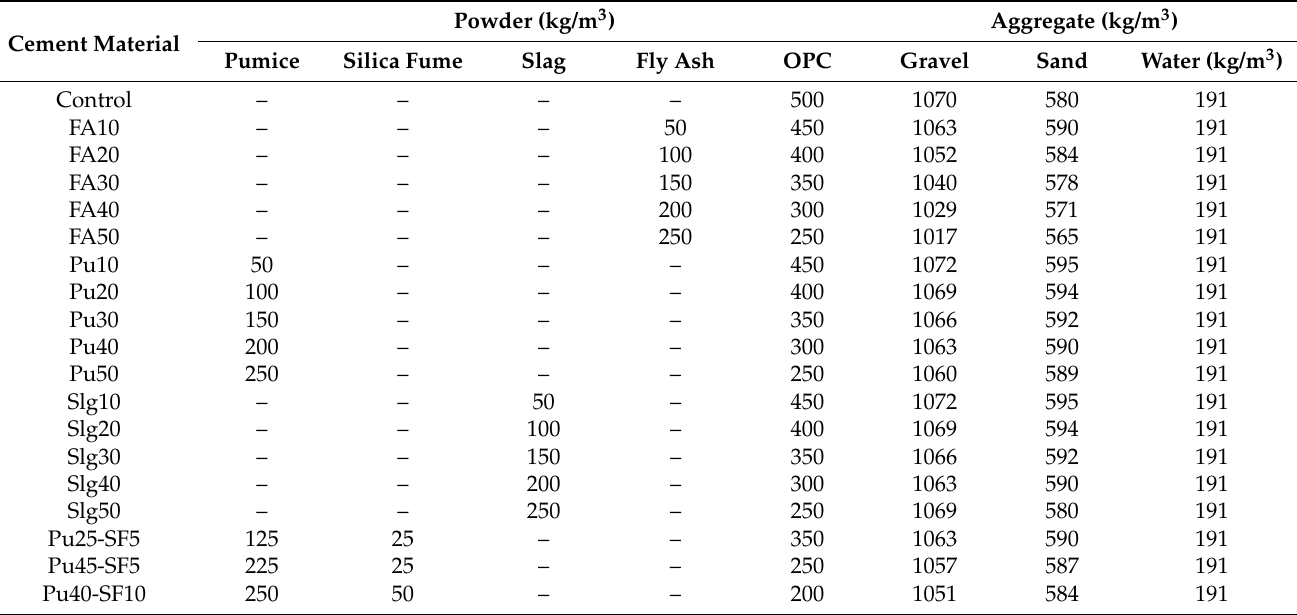
Table 2. Mix proportion of self-consolidating